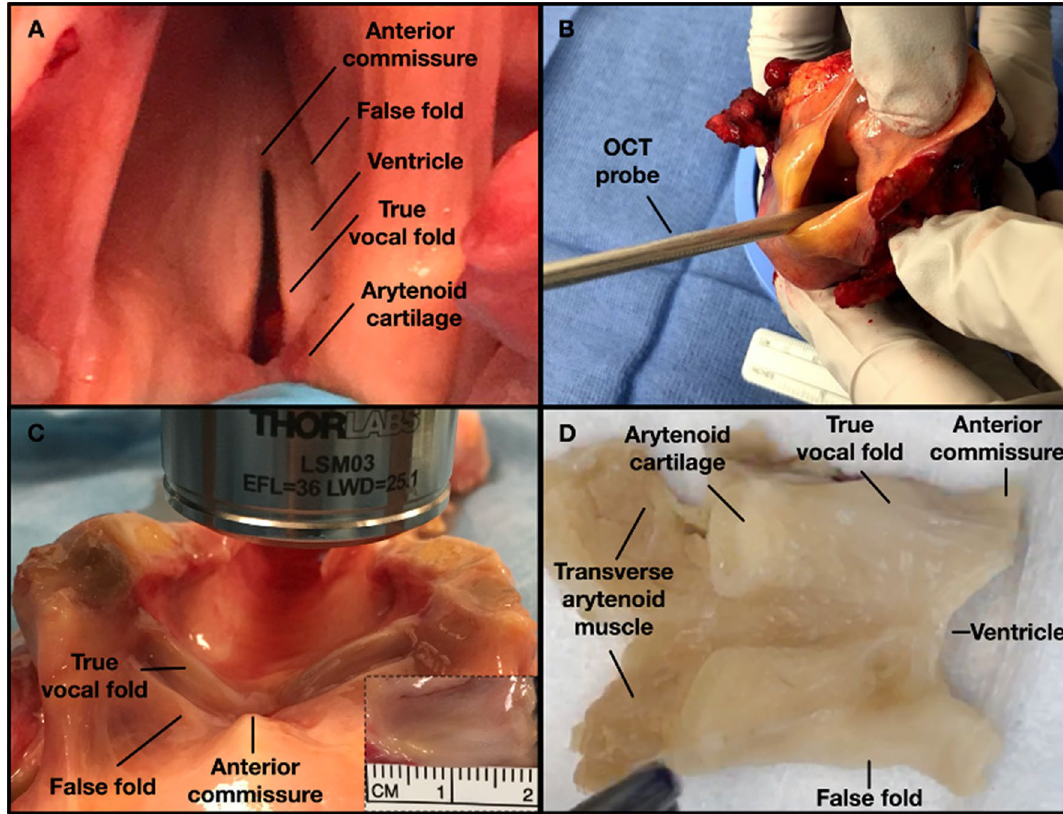
Figure 2. Experimental protocol used to characterize the vocal fold. A 66-year-old male larynx with vocal folds showing no signs of trauma (A) . The larynx was imaged under OCT with a handheld probe (B) and a bench-top system (C) for a wider field-of-view. Inset representing length measurements acquired after dissection of true and false vocal fold. Hemi-laryngeal structures ( D ) prior sectioning and after a neutral formalin